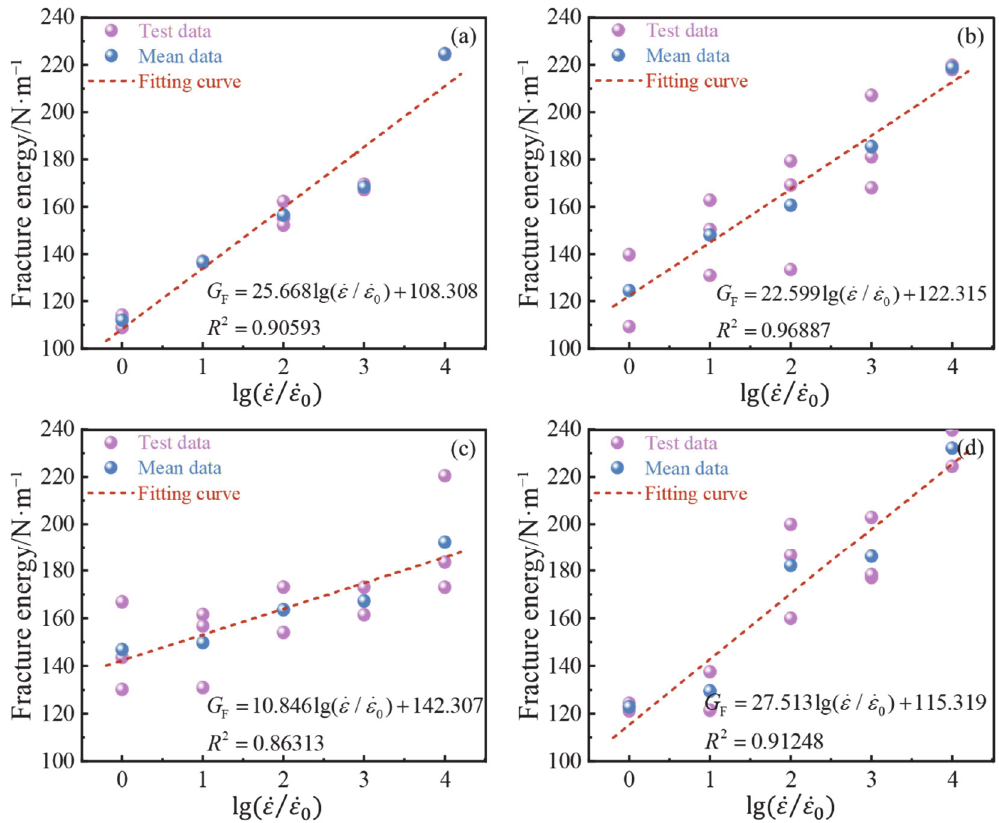
Figure 11. The relationship between the fracture energy and strain rate: ( a ) OPC; ( b ) B ‐ 0.2; ( c ) B ‐ 0.4; and ( d ) B ‐ 0.6.